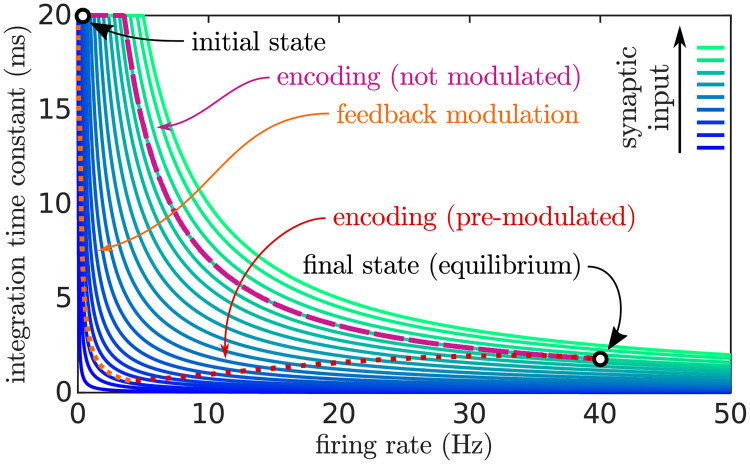
Effect of the predictive feedback mechanism on the population time constants in the spectral layer.τpop(h, I) (green-blue solid lines) depends on the firing rate h and the synaptic input I (see Methods). The figure portraits two different trajectories of the variable τpop(h, I) in the (h, I) space, both starting at an initial state (h ∼ 0 in the regime of spontaneous activity with no inputs) and finishing at an equilibrium state (with h ∼ 40 Hz). The dashed purple line shows a trajectory followed by the population when the forward synaptic input from the peripheral layer is plugged in without feedback modulation. In this case, the population reacts slowly to the strong synaptic input, and eventually converges to equilibrium. The dotted lines (orange and red) show the trajectory of the same population in the presence of feedback modulation (i.e., the facilitation currents). The low-current feedback excitatory signals drive the population to a state with a low effective time constant without substantially increasing its firing rate (orange section of the trajectory). When the strong synaptic input from the auditory periphery is switched on (red section of the trajectory) the population reacts quickly to the synaptic input, reaching equilibrium much faster than in the non-modulated case.